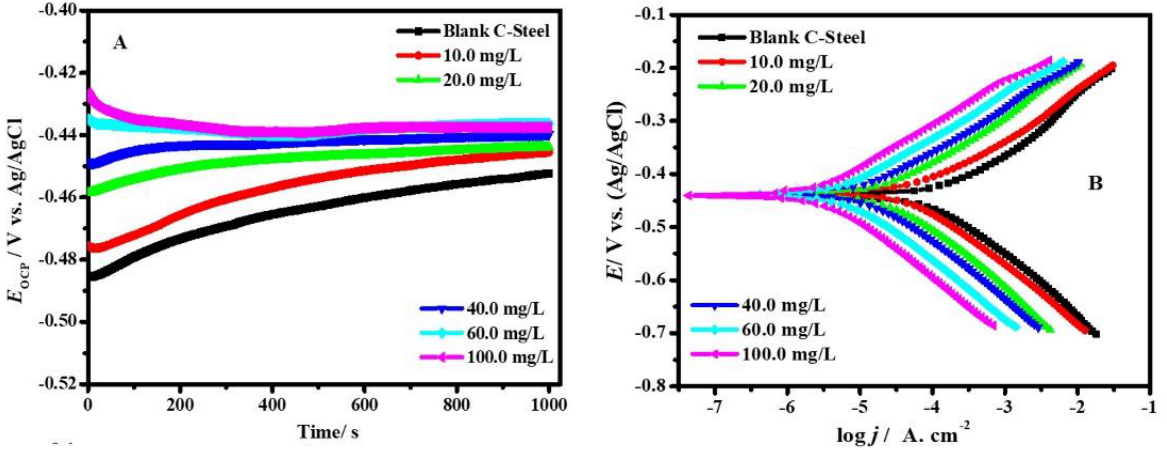
Figure 6. E OCP vs. t ( A ) and PDP graphs ( B ) of CS-alloy corrosion in the blank molar HCl containing 3.5% NaCl and with adding various doses of ZnTiO@PANi at 25 °C.